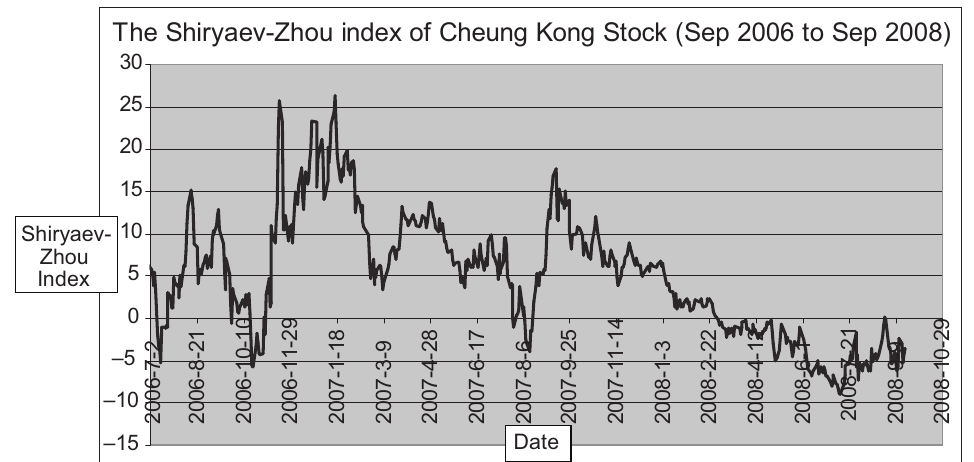
figure 4. The shiryaev-Zhou index of Cheung Kong